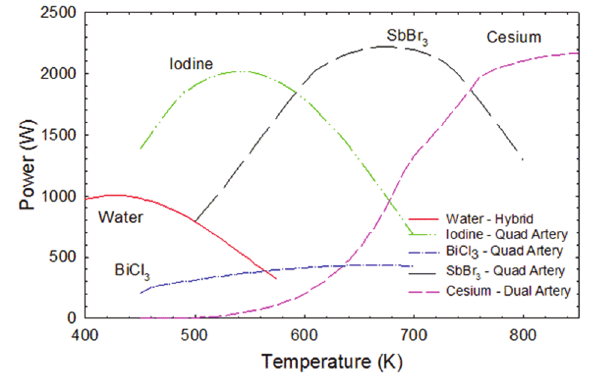
Fig. 5. Theoretical heat pipe power for different fluids [20]